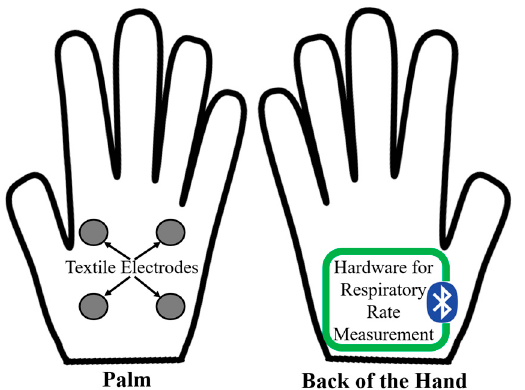
Figure 2. Position of textile electrodes and hardware system in proposed textile glove for RR monitoring.